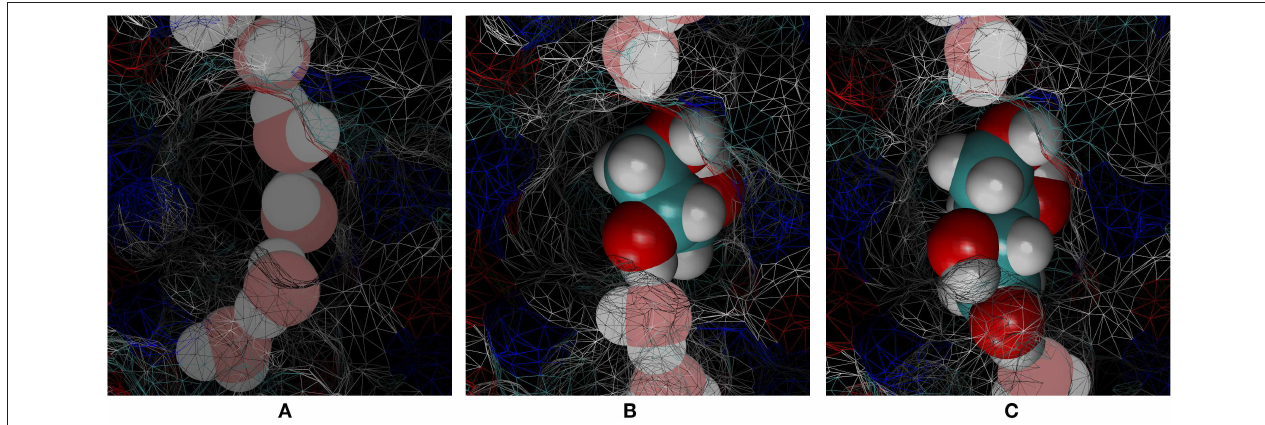
FIGURE 6 | Cavity of the binding site inside the PbAQP channel near the NLA-NPS motifs. (A) Waters line up in single file occupying a smaller portion of the cavity. (B) Glycerol fits loosely in the cavity but totally interrupts the single file of waters. (C) Erythritol fits snuggly in the cavity and totally interrupts the single file of waters. Waters are shown in large spheres chalk colored by atoms. Glycerol and erythritol are shown in large spheres brightly colored by atoms. The protein is partially shown as wireframe surface colored by atoms.